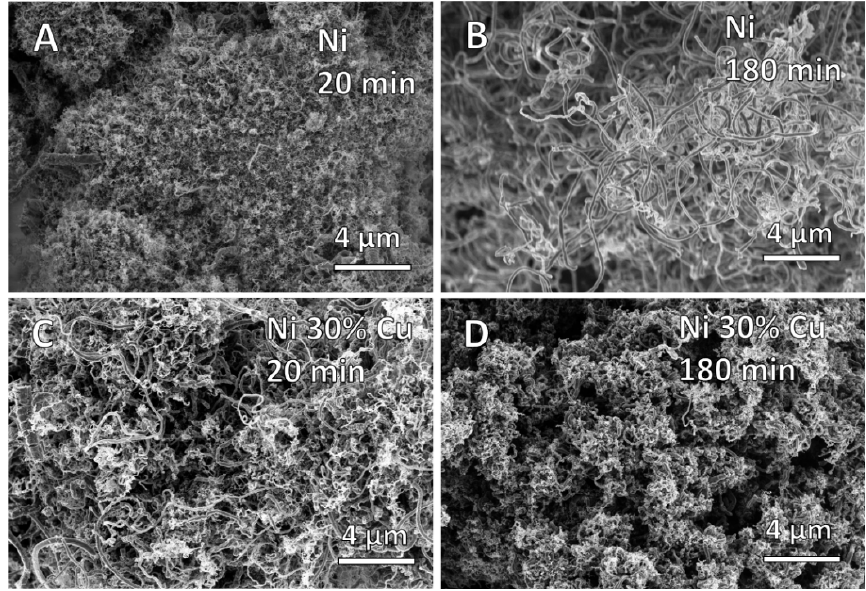
Figure 5. Carbon nanofibers deposited on Ni milled for 20 min ( A ); Ni milled for 180 min ( B ); Ni 30 at % Cu milled for 20 min ( C ) and Ni 30 at % Cu milled for 180 min ( D ) at 550 °C with C 2 H 4 :H 2 (4:1).